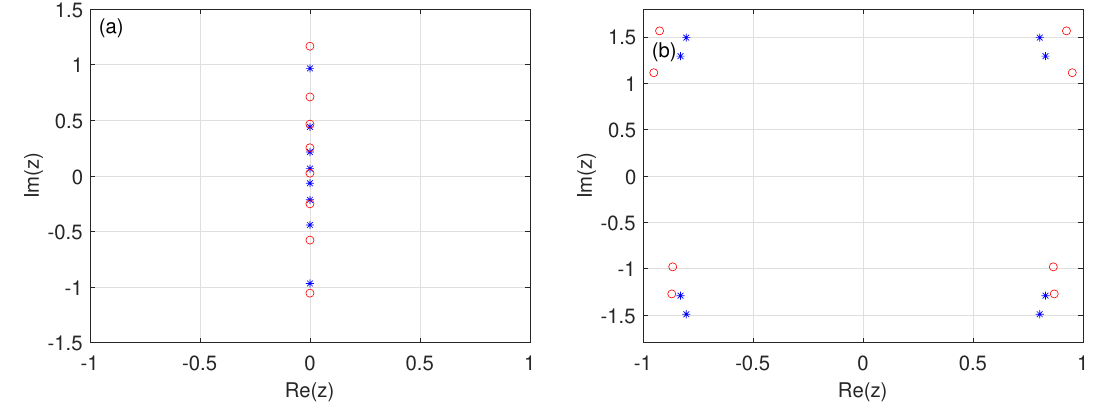
Figure 1 . The distribution of zero roots { z j } of Λ( u ) at the ground state for N = 9 via ex- act diagonalization. (a) η = 0 . 75 and (b) η = 0 . 75 + iπ . The blue stars are the results for { θ j = 0 } , and the red circles are the results for arbitrarily chosen inhomogeneity parameters as 0 . 14 i, 0 . 32 i, − 0 . 43 i, 0 . 54 i, − 0 . 25 i, 0 . 63 i, 0 . 47 i, − 0 . 78 i, 0 . 19 i